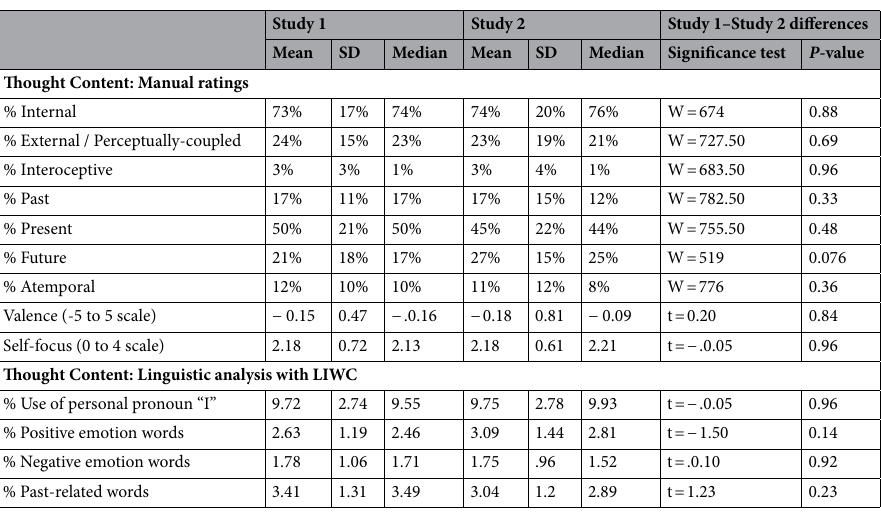
Table 2. Content characteristics in Study 1 and 2 assessed manually by rater (top) and with Linguistic Inquiry Word Count (LIWC) software (bottom). Statistical differences between Study 1 and 2 were evaluated with a two-tailed Welch t-test for normally distributed variables and a Wilcoxon rank-sum test for non-normally distributed variables. MNW Mean Number of